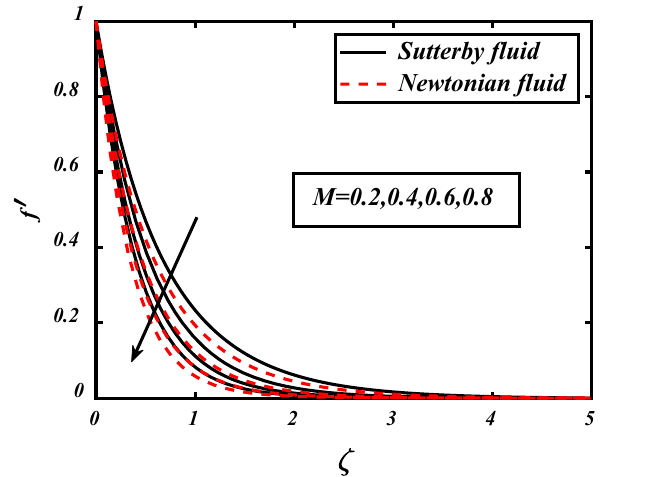
Figure 3. Expounds the impacts of M on f ′ .